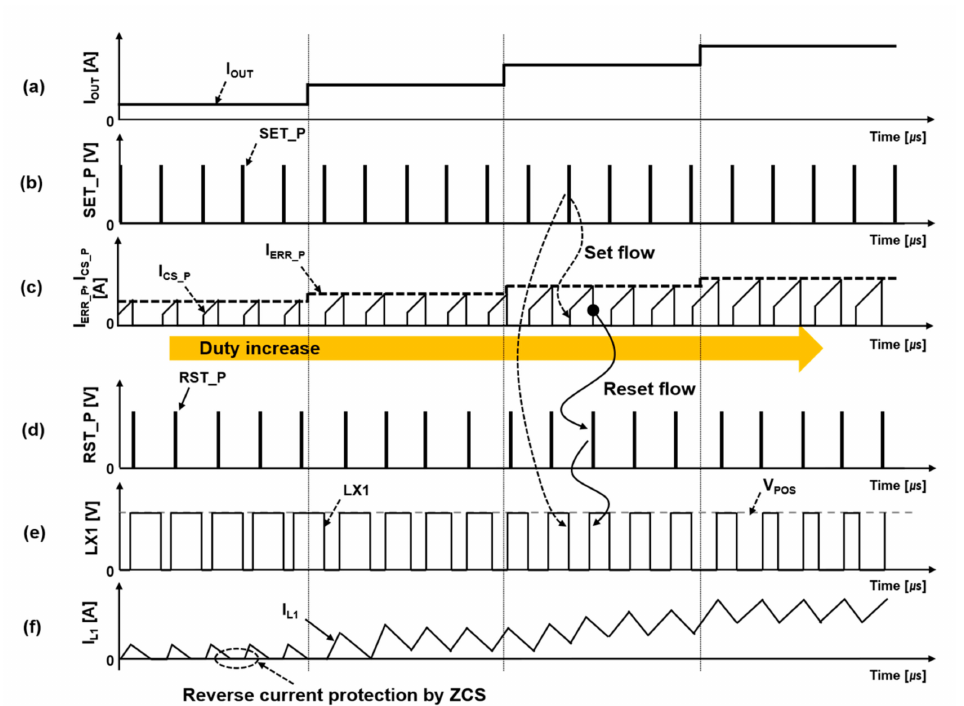
Figure 5. Timing diagram of the PWM mode operation of the boost converter: ( a ) I OUT ; ( b ) SET_P; ( c ) I ERR_P and I CS_P ; ( d ) RST_P; ( e ) LX1; ( f ) I L1